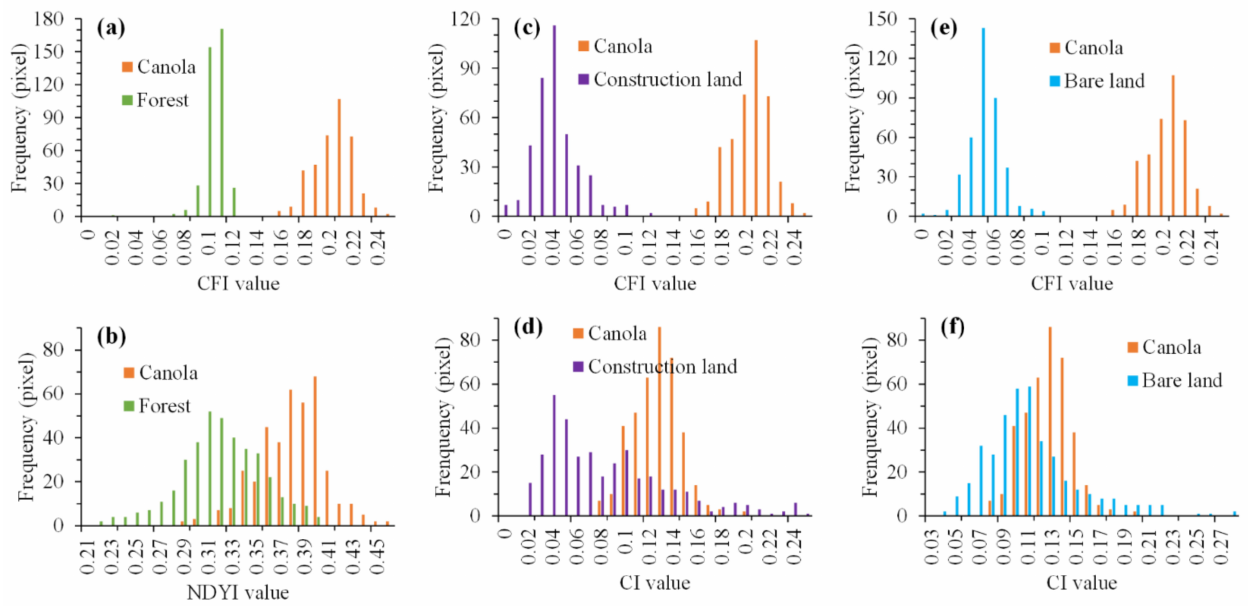
Figure 10. Histograms of various objects based on various canola flower indices. ( a , c , e ) Histograms of canola, forest, construction land, and bare land based on CFI values. ( b ) Histograms of canola and forest based on NDYI values. ( d , f ) Histogram of canola, construction land, and bare land based on CI